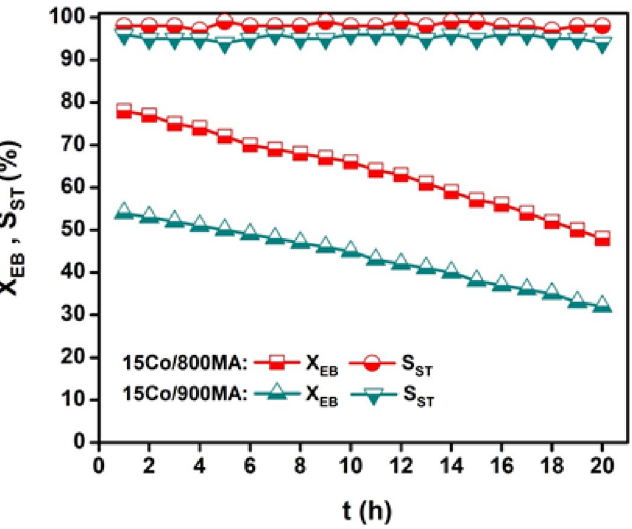
Figure 8. TOS on regenerated cobalt catalysts under CO 2 flow (reaction conditions: T = 600 °C, catalyst = 0.7 g, CO 2 flow rate = 30 mL/min, EB flow rate = 1.5